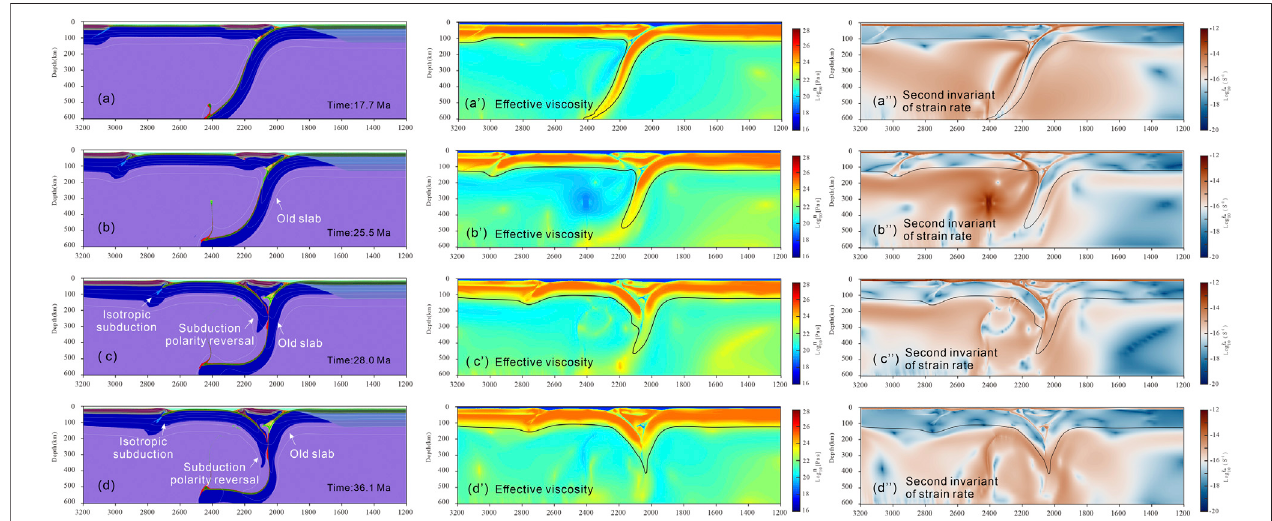
FIGURE 7 | Evolutionary process of Model4. Panels (A – D) , (a ’ -d ’ ) , and (a ’‘ -d ’‘ ) show rock composition, effective viscosity, and second invariant of strain rate at differenttimesteps,thatis,17.7,25.5,28.0and36.1 Ma,respectively.Thecolorbarsofviscosityandstrainrateareshownontheleft,whilethecolorbarofcomposition is shown in Figure 2